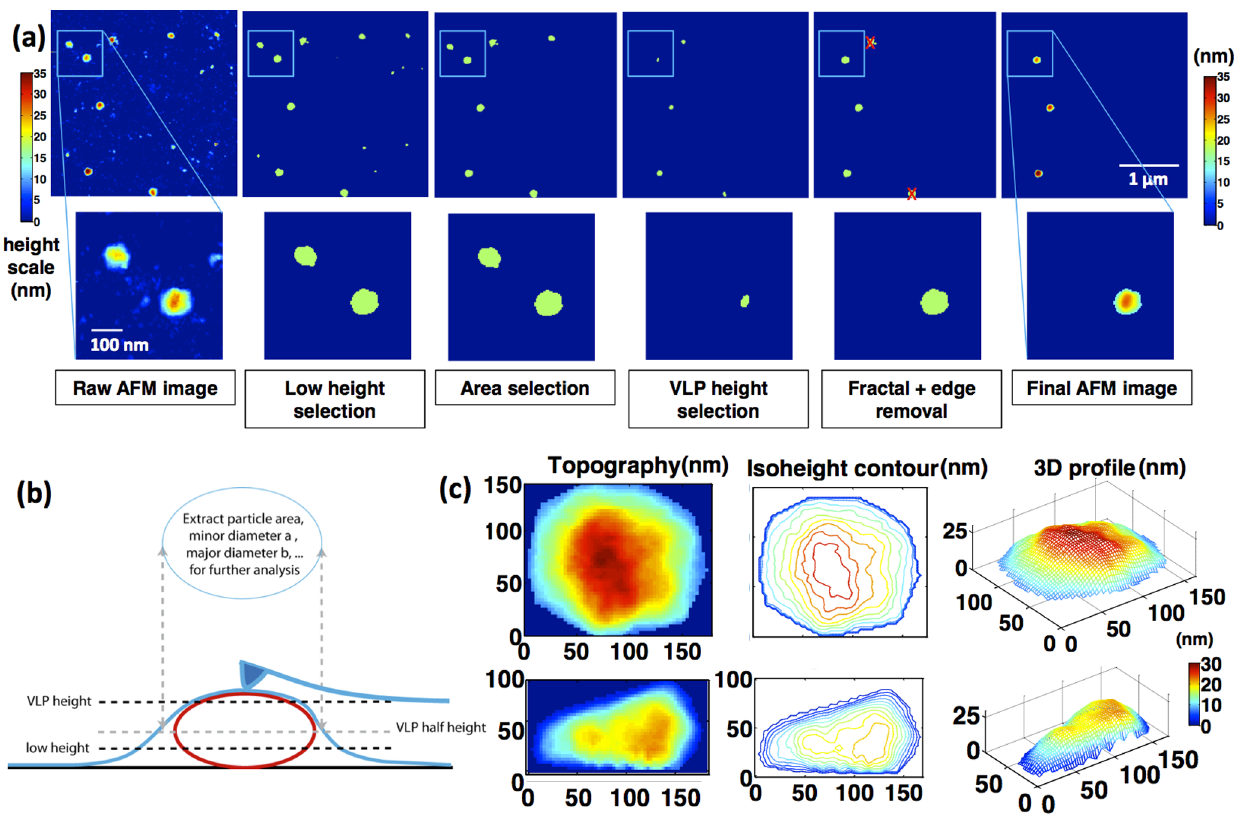
Figure 2. Automated image analysis. (a) Example of the successive image analysis steps applied on a single image. (b) Cartoon of the principle of image analysis. (c) Various representation (color map, contour plots, 3D plots) of particles that were selected. Top VLP, down core. Interestingly, the contour map of the VLP shows a pronounced asymmetry close to its maximal height, reflecting the presence of an asymmetric object inside the VLP.